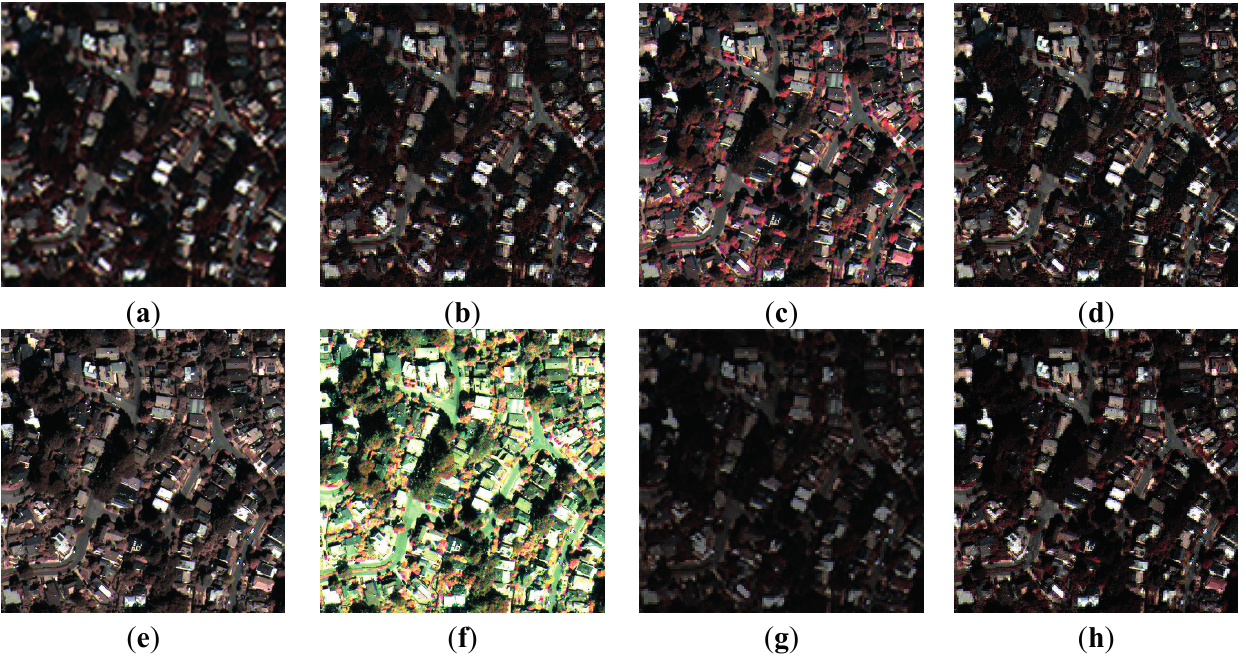
Figure 14. ( a ) Multispectral Image of resident image. ( b ) BEMD fusion image. ( c ) IHS fusion image. ( d ) Wavelet fusion image. ( e ) PCA fusion image. ( f ) Brovey fusion image. ( g ) Gaussian high-pass spatial filter fused image. ( h ) Laplacian pyramidal decomposition